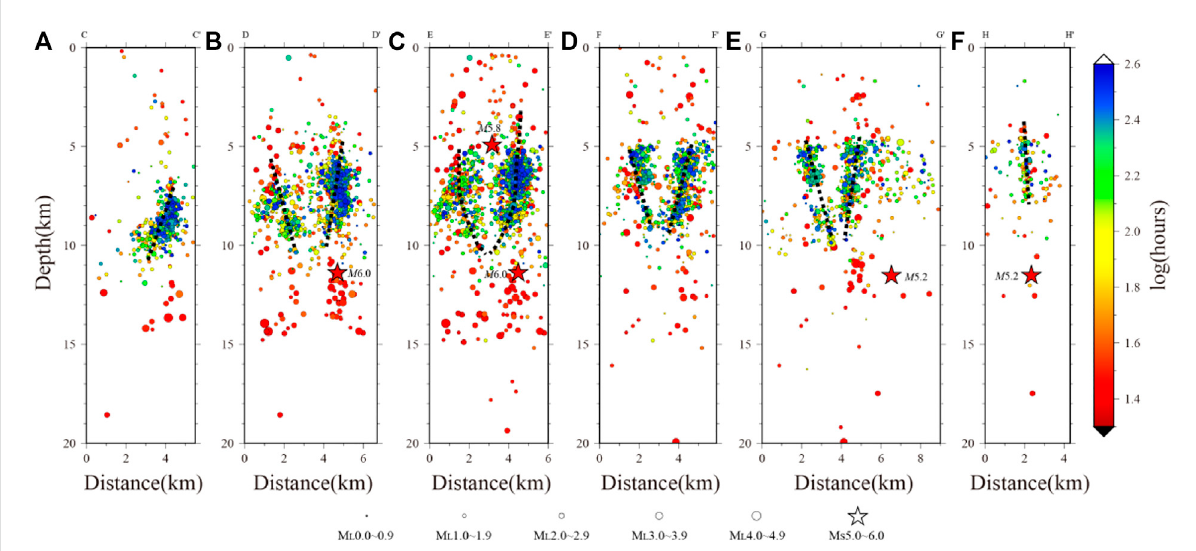
FIGURE 8 Focal depth projection along pro fi les CC ′ – HH ′ . Dashed lines indicate inferred seismogenic structures. (A) : pro fi le AA ′ , (B) : pro fi le DD ′ , (C) : pro fi le EE ′ , (D) : pro fi le FF ′ , (E) : pro fi le GG ′ , (F) : pro fi le HH ′ .